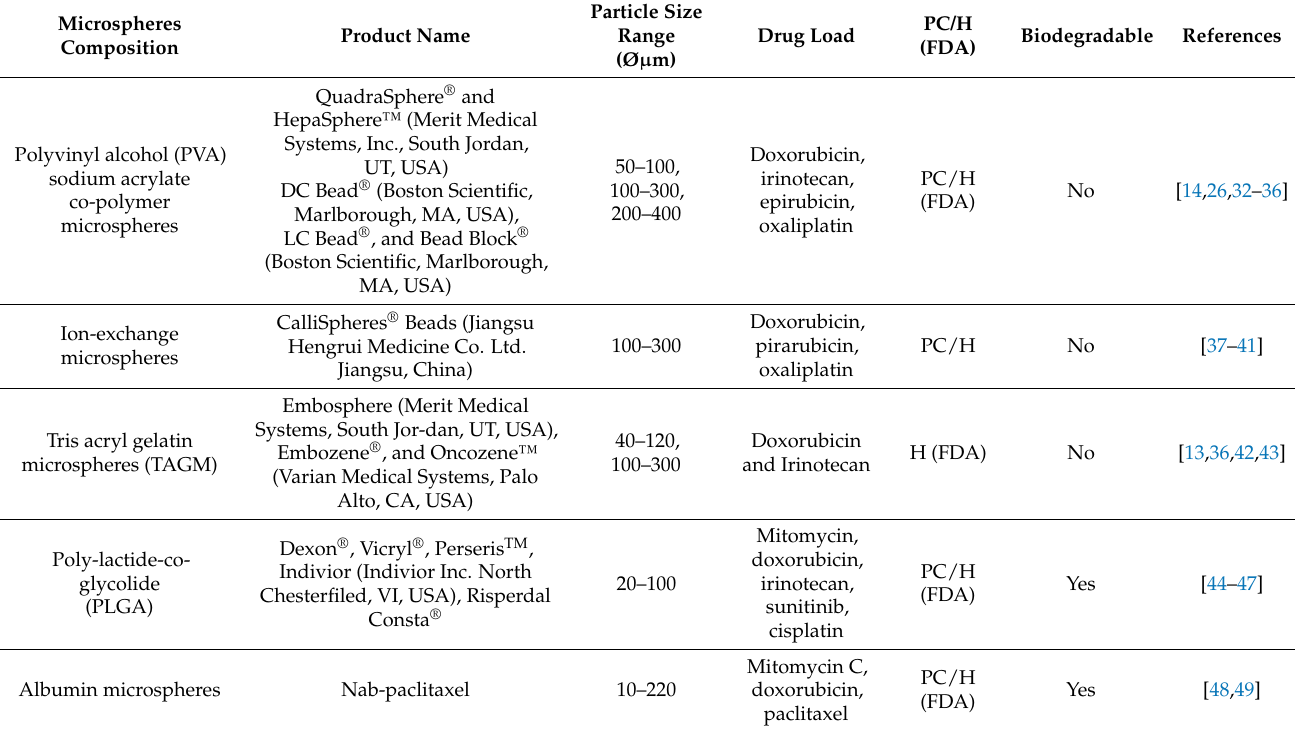
Table 3. Drug-eluting microspheres for functionalized hepatic TACE. PC = pre-clinical use, H = human use, FDA = FDA approved as an active implantable medical device. See Section 4 for a detailed evaluation of the